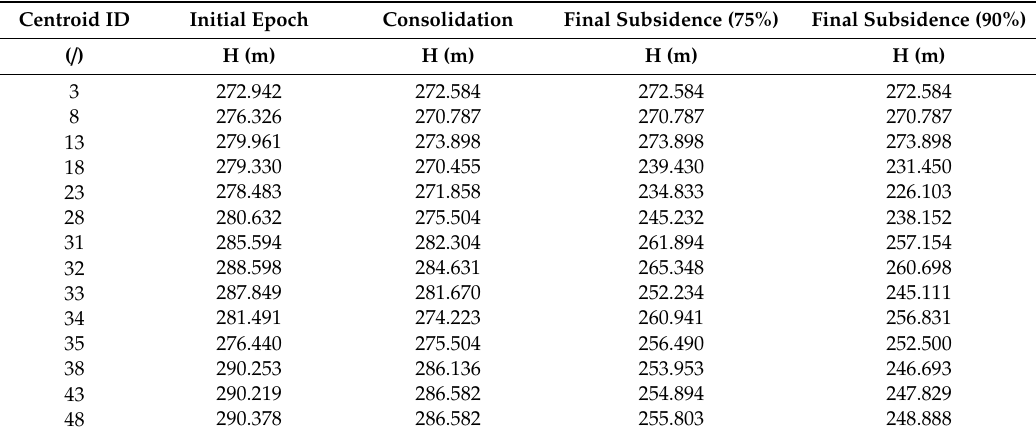
Table 6. Heights of the calculated centroids on profiles Cw7 and CL3 in the initial epoch, in consolidation prognosis with the FNSE model, and in the final subsidence prognosis.